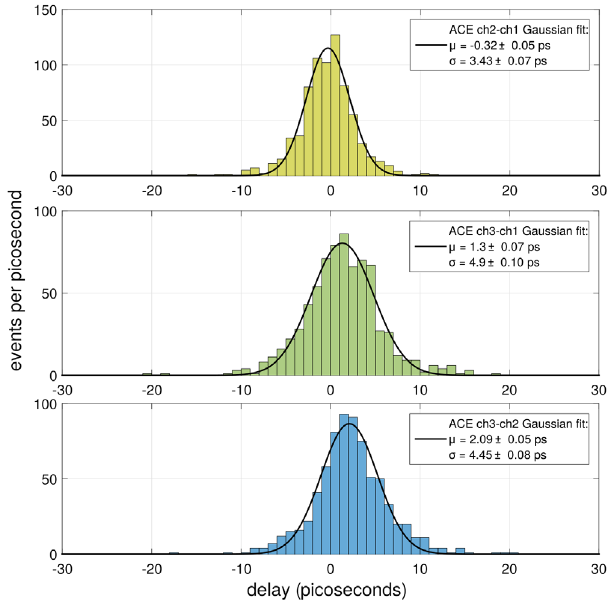
FIG. 14. Relative time resolution of the three ACE detector elements taken in pairs. Top: ACE2 vs ACE1; middle: ACE3 vs ACE1; bottom: ACE3 vs ACE2. The width of each distribution is thus a convolution of the intrinsic timing resolution of the two elements used in each case, increasing the intrinsic width by ffiffiffi p ∼ 2 . In each case an overall constant approximately equal to the channel-to-channel delay has been